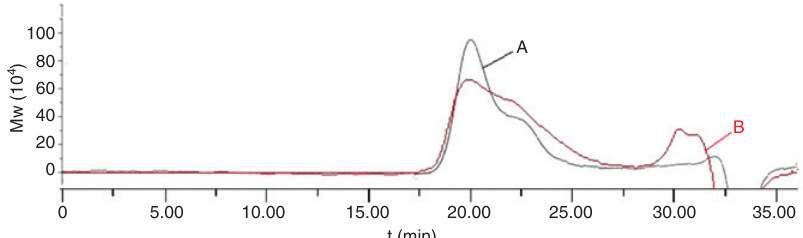
Figure 6: The test pattern of the molecular weight. Curve A – sample without adding α -hydroxylethyl ferrocene, curve B – sample adding α -hydroxylethyl